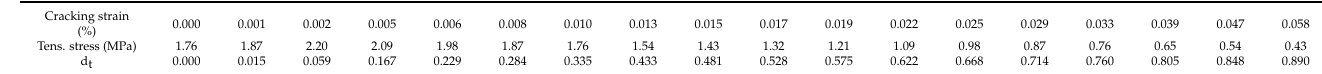
Table 7. Relationship of tensile stress, cracking strain, and damage factor of concrete(c35).